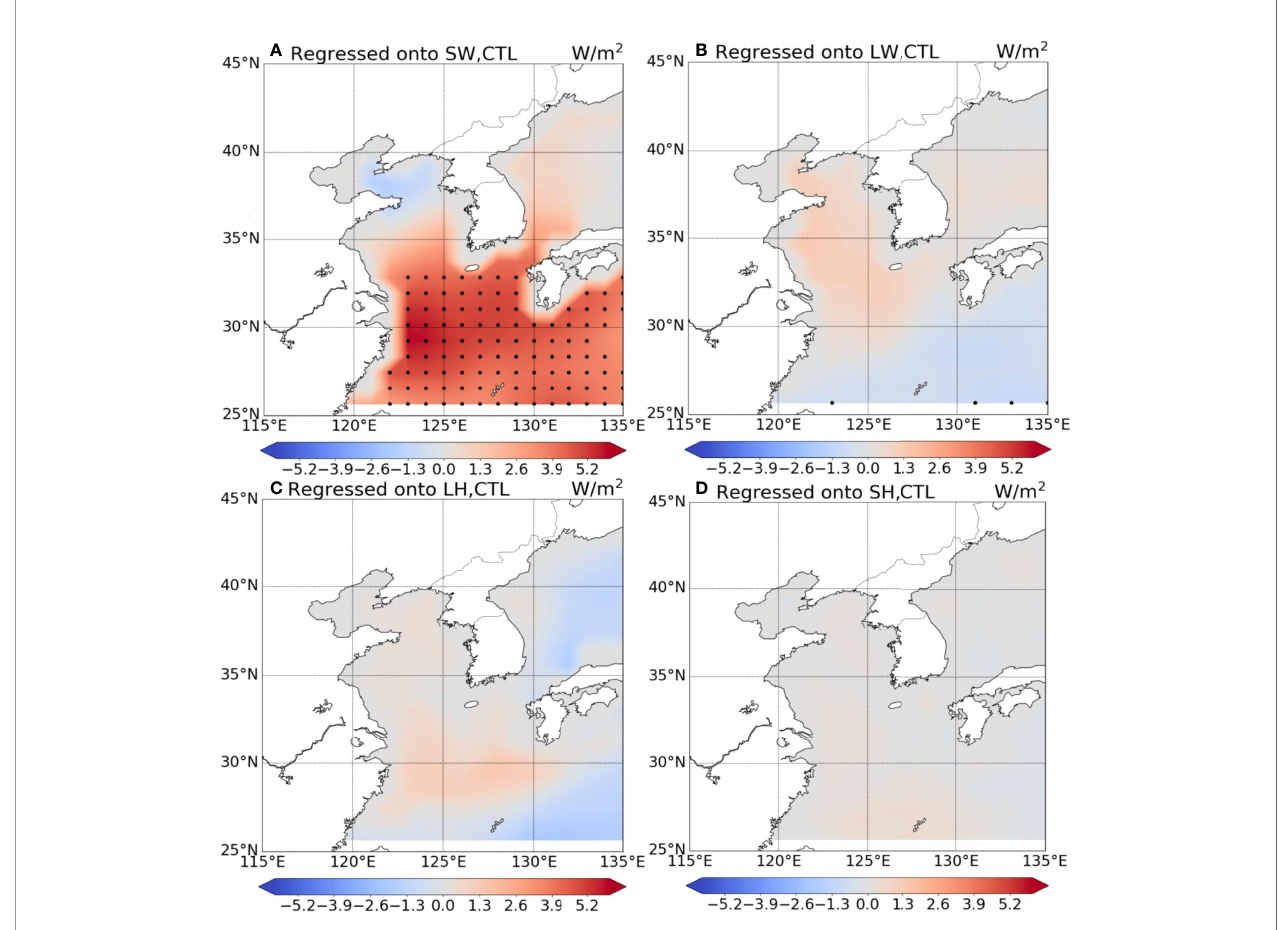
FIGURE 9 | Regression maps of shortwave radiation (A) , longwave radiation (B) , latent heat fl ux (C) and sensible heat fl ux (D) against with the EOF 1 PC time series in Exp_CTL. The dots on the map indicate the statistical signi fi cance at the 95% con fi dence